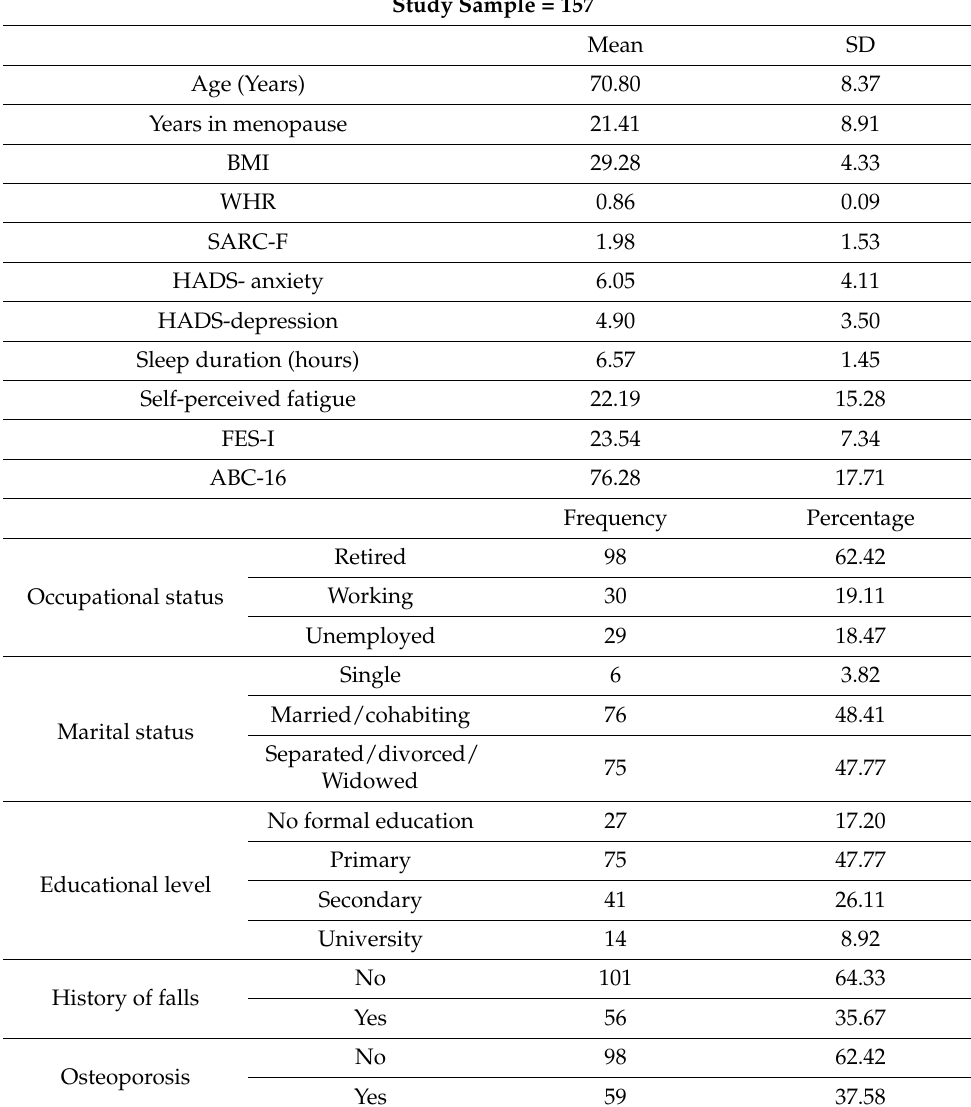
Table 1. Descriptive data of the participants in this